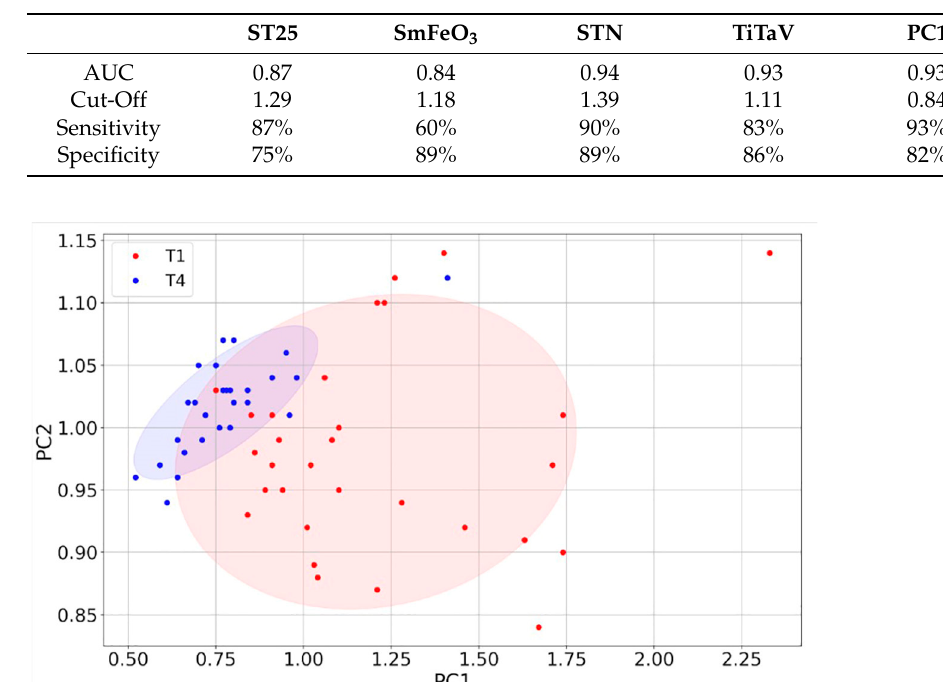
Figure 7. Evaluation of the sensor sensitivity and specificity in discriminating between T1 and T4. Plots of the ROC curves of the four sensors resulting from 1000 iterations. Table 3. Main parameters characterizing the sensor and the device performances. The first four columns shows the AUC, cut-off, sensibility and specificity for each of the four sensors calculated from the ROC curves of Figure 7; the last column shows the parameters derived from the ROC curve (calculated on the basis of the PC1 data projection of Figure 8) globally characterizing the new device equipped with the four sensors (Figure 9).